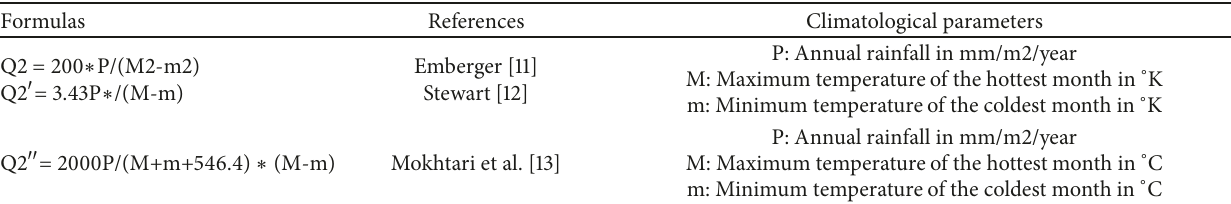
Table 1: Emberger's bioclimatic Quotient formulas.